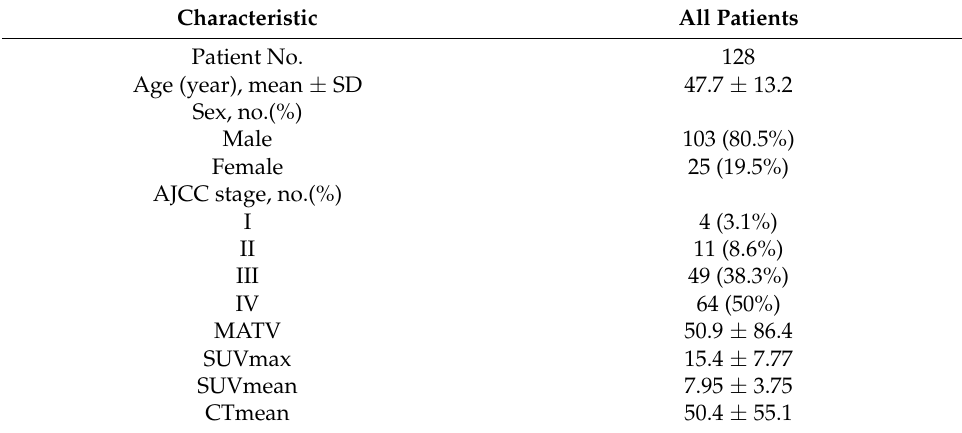
Table 1. Clinical characteristics of the NPC patients. Characteristic